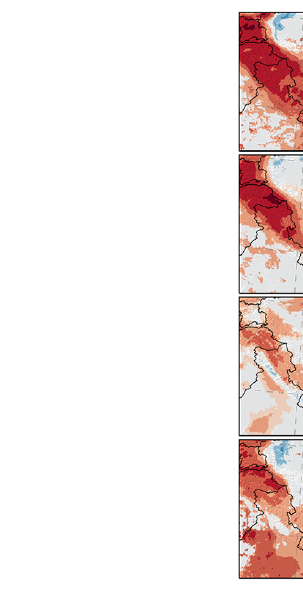
Figure 7. Coefficient of correlation (rho) between atmospheric water transport (AWT) and precipitation for all months (01–12). Positive correlations are denoted in red, while negative correlations are denoted in